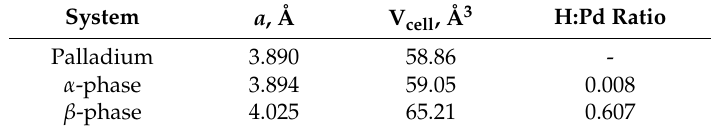
Table 1. Lattice constant and corresponding unit cell volume evaluated at 20 °C.